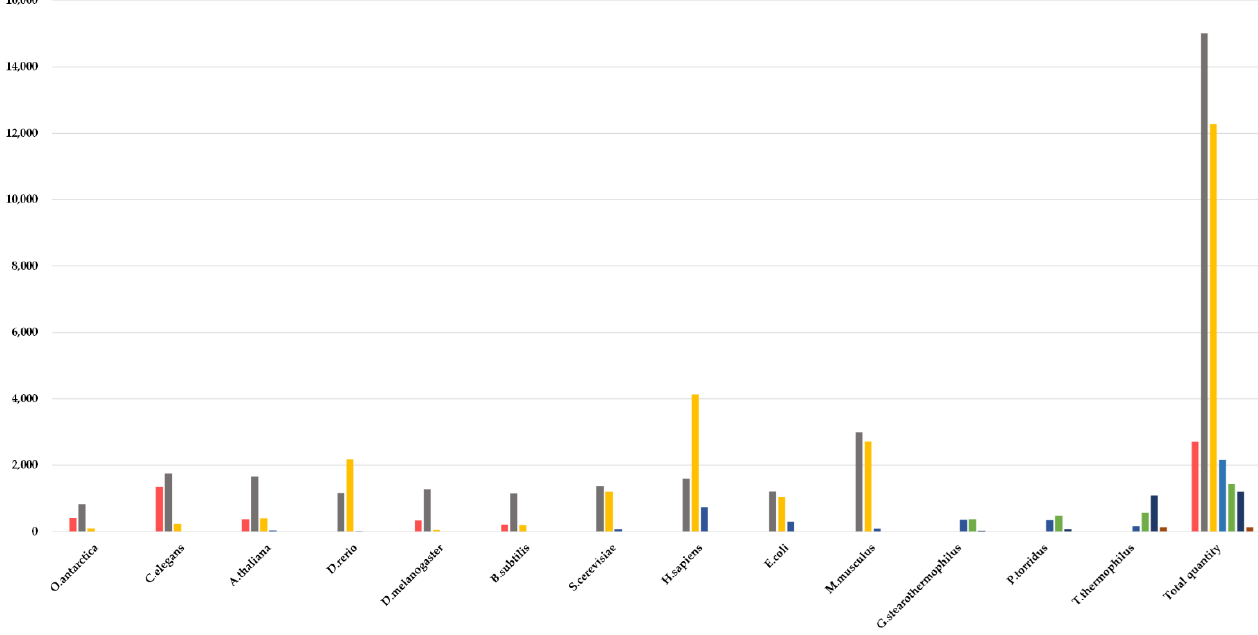
Figure 1. Distribution of T m values for proteins in each species. Proteins were binned and color-coded as follows: <30 °C pale blue, between 30 and 40 °C red, between 40 and 50 °C gray, between 50 and 60 °C orange, between 60 and 70 °C blue, between 70 and 90 °C green, between 80 and 90 °C dark blue, and over 90 °C brown.